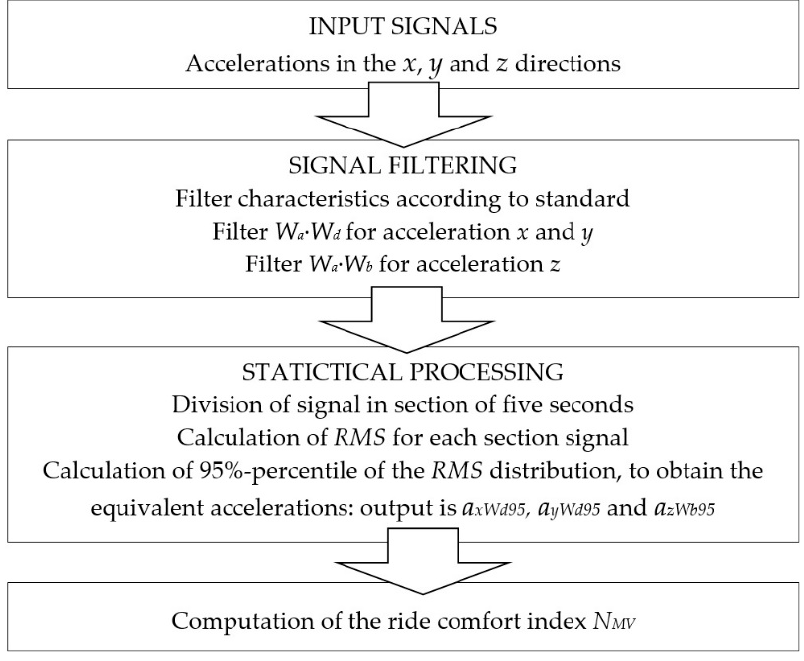
Figure 2. The calculation process for the ride comfort index N MV .